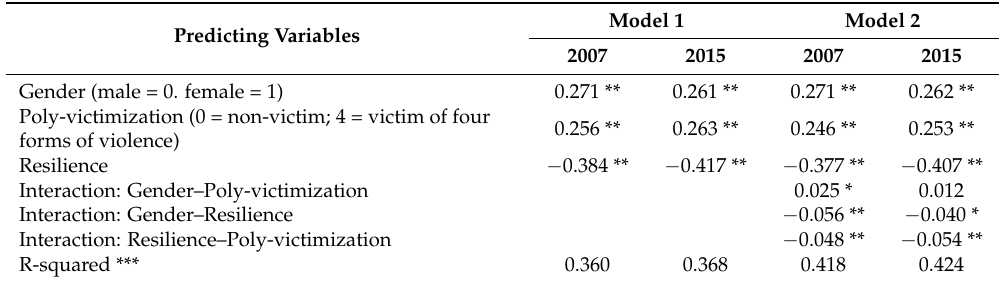
Table 3. Standardized coefficients of poly-victimization and resilience regression on poor mental health (HSCL scale